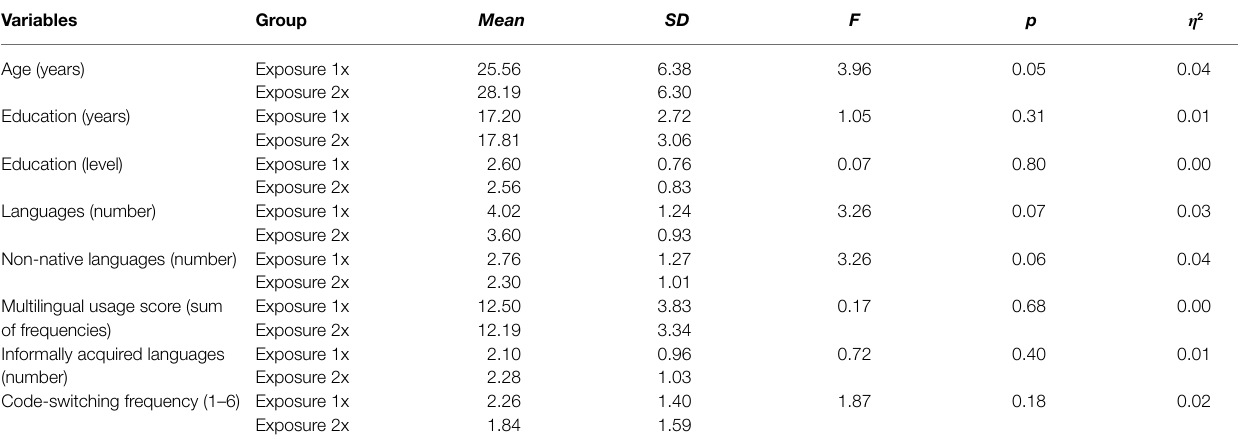
TABLE 1 | Demographic and linguistic background variables by exposure group.